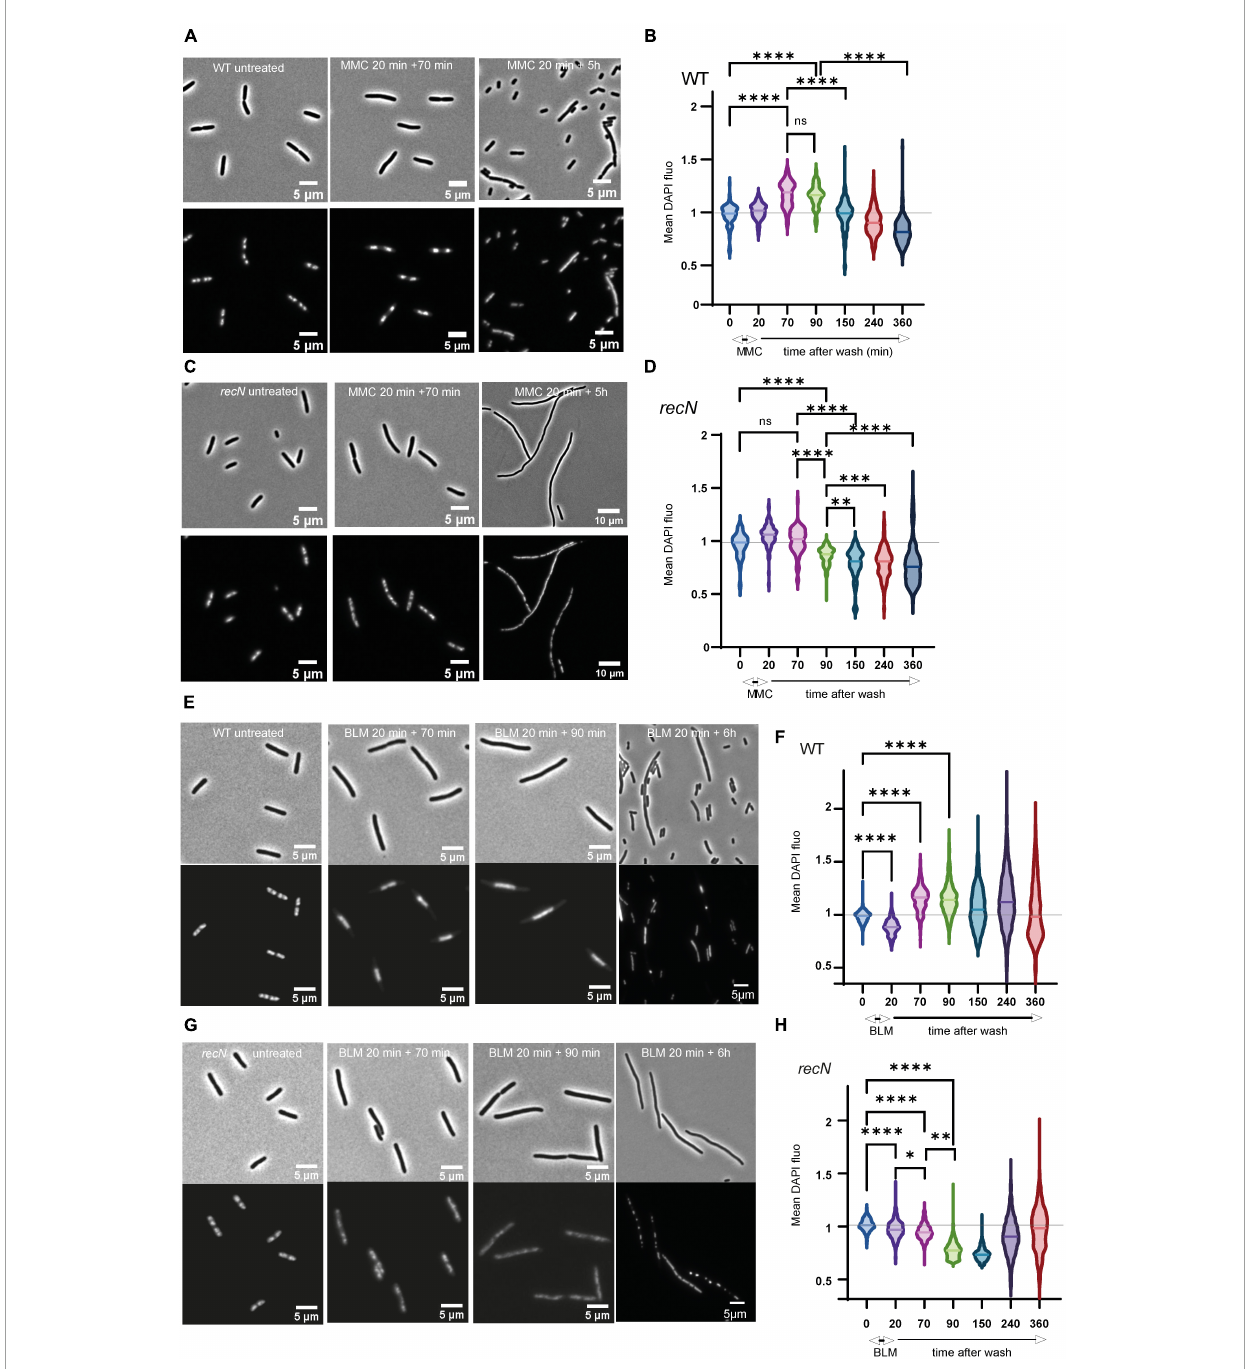
FIGURE2 RecN’s influence of nucleoid compaction. (A) Observation of cells and nucleoid of WT cells treated with MMC (B) quantification of the mean DAPI fluorescence in the nucleoid area of WT cells treated with MMC. Integrated fluorescence amount in the nucleoid divided by the area of the nucleoid is a proxy for nucleoid compaction. (C) Same as A for the recN mutant. (D) Same as B for the recN mutant. (E) Observation of cells and nucleoid of WT cells treated with BLM. (F) Quantification of the mean DAPI fluorescence in the nucleoid area of WT cells treated with BLM. (G) Same as D for the recN mutant. (H) Same as F for the recN mutant. N = 500, Anova statistical test ∗ < 0.05, ∗∗ < 0.005, ∗∗∗ < 0.0005, ∗∗∗∗ < 0.00005.